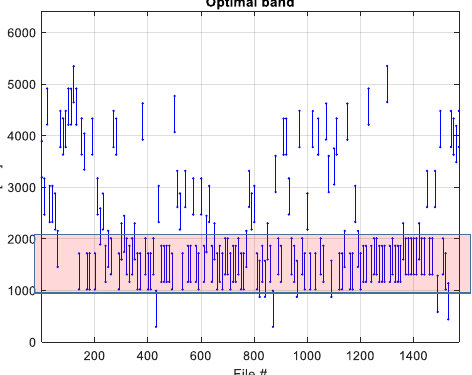
Figure 3. Definition of the optimal frequency band for filtering the residual signal according to the RCC index—left TB.